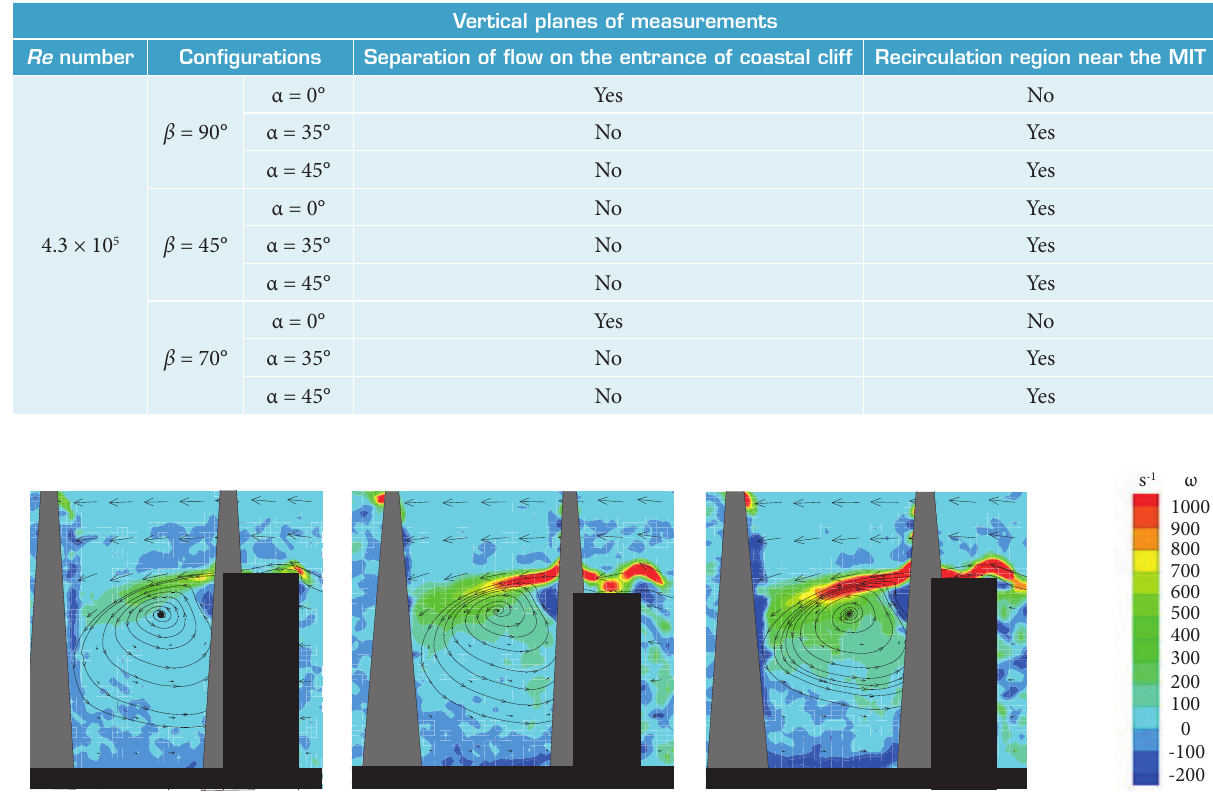
Table 1. Flow pattern characteristics in vertical planes of measurements in the MIT neighborhood.